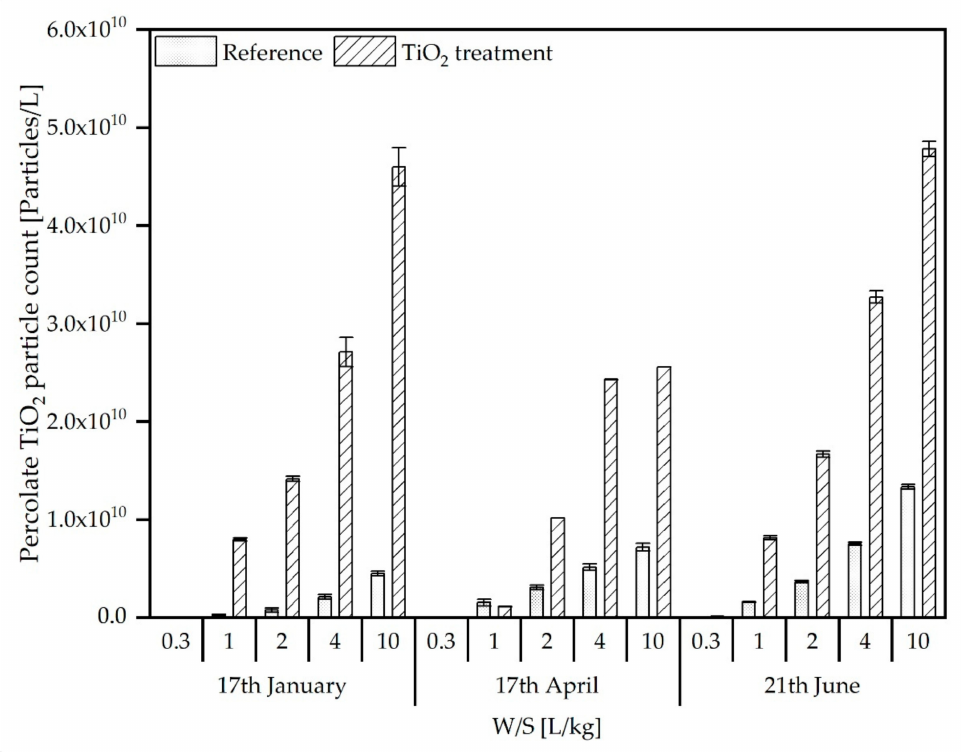
Figure 6. nTiO 2 particle concentrations (Particles/L) determined in column percolates from reference and nTiO 2 treated SSA/soil mixtures out of pilot scale simulation reactors collected at three different sampling